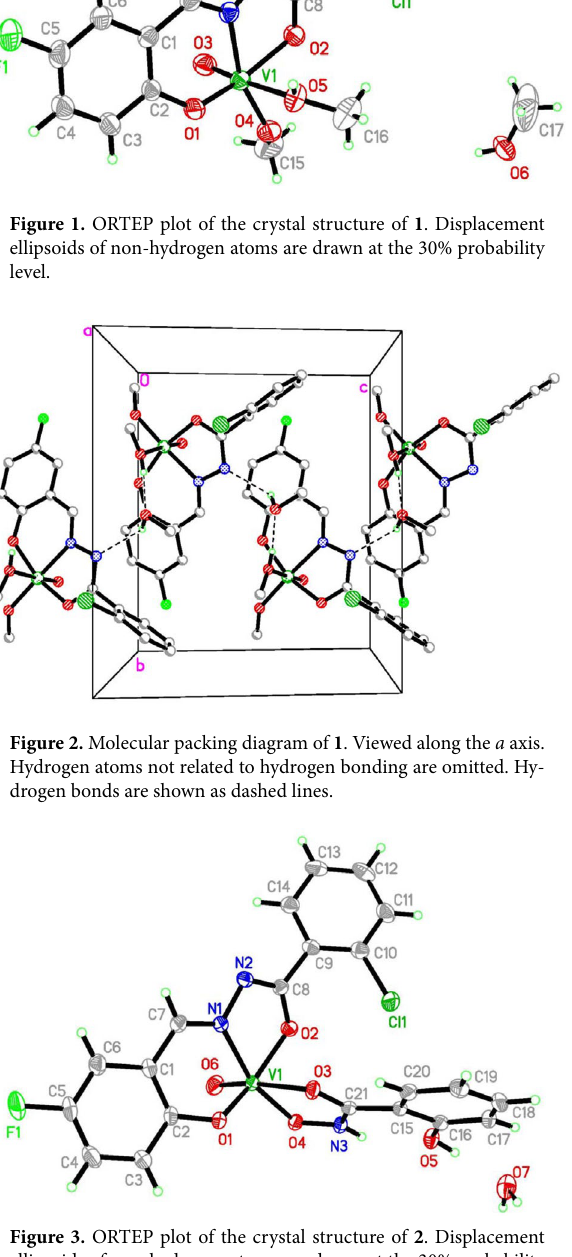
Figure 3. ORTEP plot of the crystal structure of 2 . Displacement ellipsoids of non-hydrogen atoms are drawn at the 30% probability level.